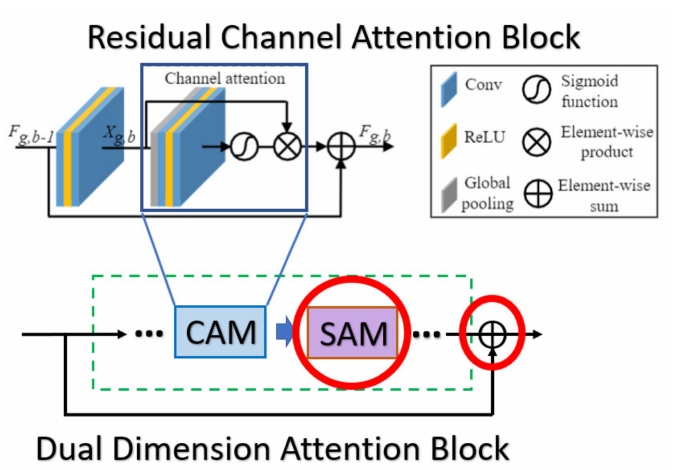
Figure 20. The main difference between the RCAB and the DDAB. The red solid circles indicate the additional parts in our module DDAB.